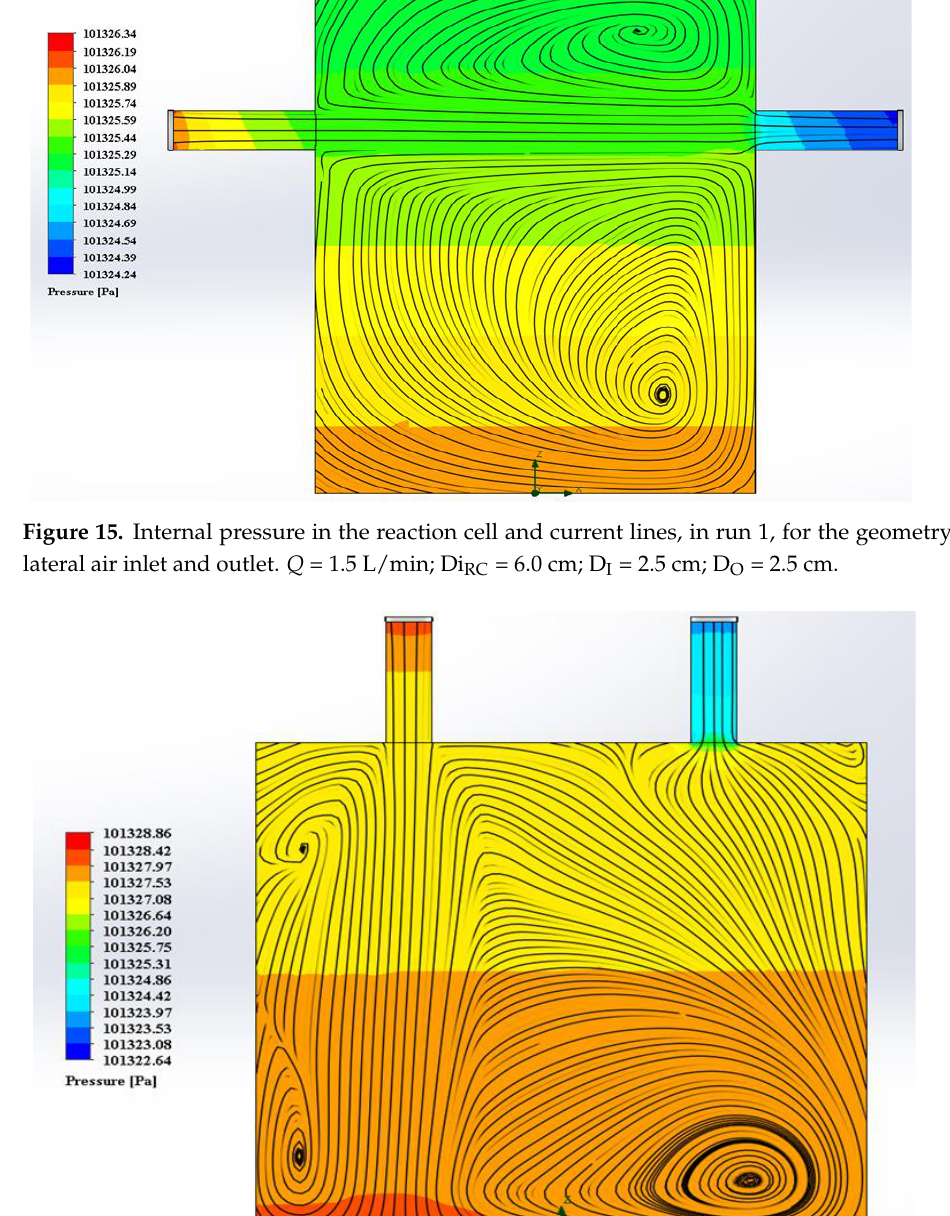
Figure 14. Air velocity in reaction cell and current lines, in run 1, for the geometry with upper air inlet and outlet. Q = 2.5 L/min; Di RC 8.0 cm; D I = 2.0 cm; D O = 2.0 cm.